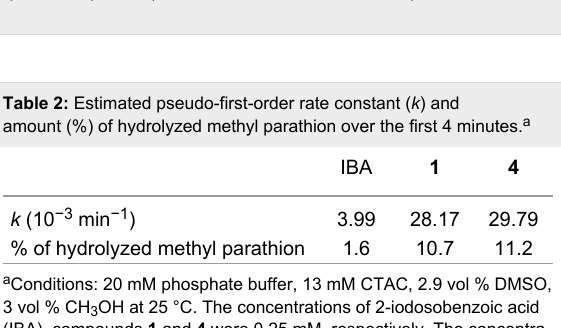
Figure 10: Influence of TRIMEB, IBA and imidazole on the hydrolysis of methyl parathion (0.5 mM). The final concentrations of compounds 2 , 4 , 2-iodosobenzoic acid (IBA), imidazole and TRIMEB were 0.25 mM.